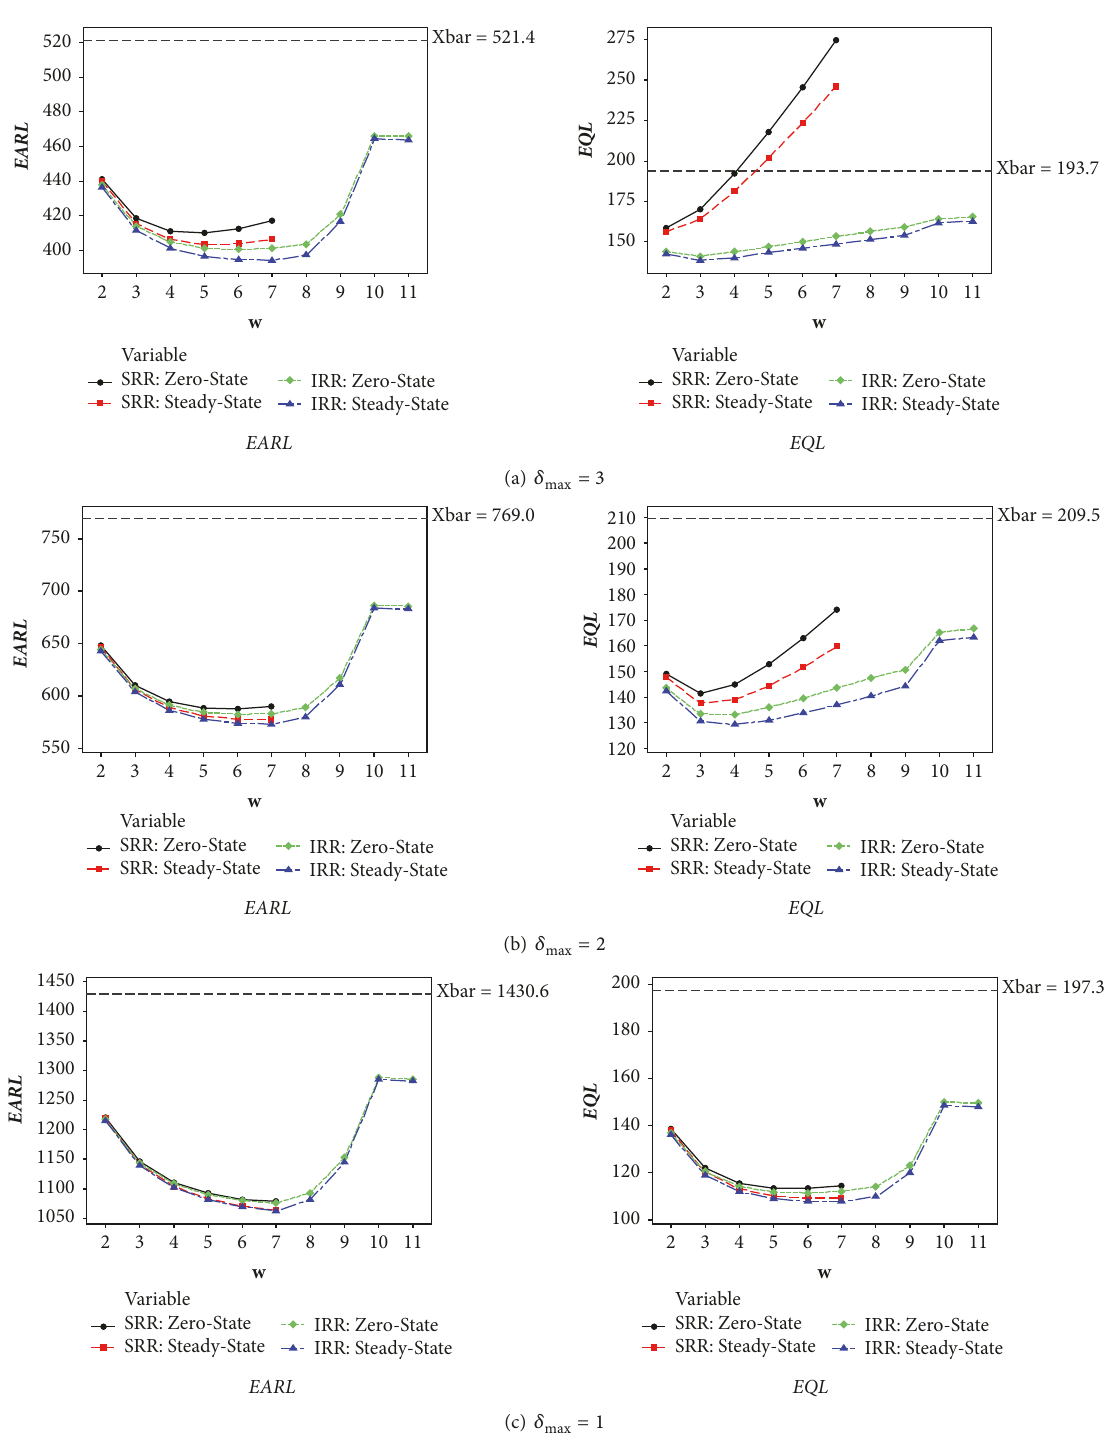
Figure 2: The zero-state and steady-state EARL and EQL values (with 𝛿 min = 0 ) of the one-sided SRR and IRR schemes when ARL 0 = 370.4.